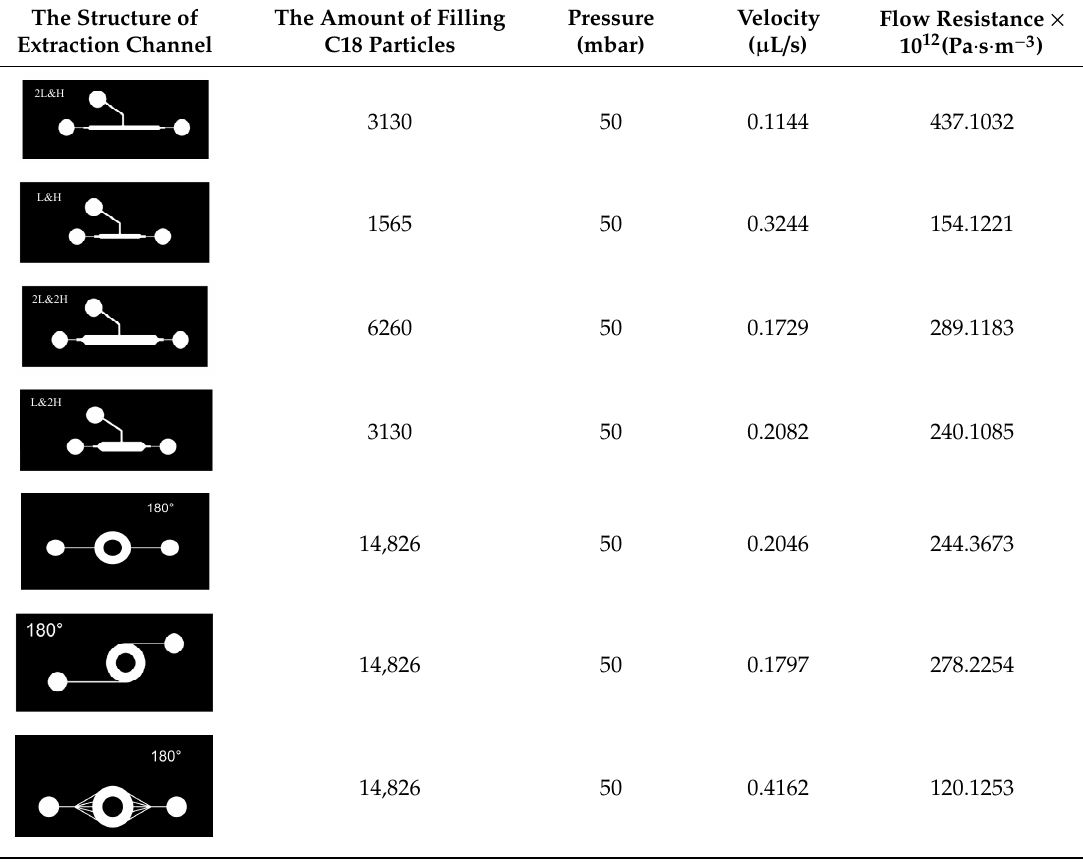
Figure 5. COMSOL velocity field simulation diagram of the chip disk shaped extraction channel. Table 1. Determination of the flow resistance of the extraction channel. We filled the C18 particles into the extraction channel and then drove the water into the extraction channel. The flow rate was measured by the flow detector.